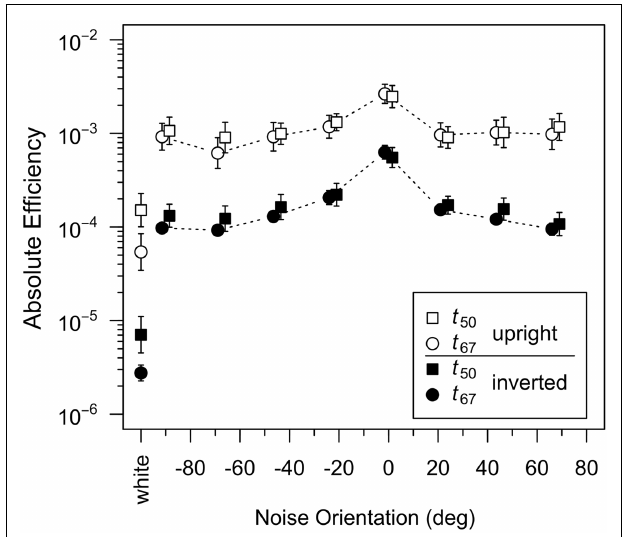
FIGURE 5 |Absolute efficiency measured in the t 50 and t 67 groups plotted as a function of noise orientation for upright and inverted faces. The leftmost symbols represent efficiency in the white noise condition. Absolute efficiency is defined as the squared ratio of ideal and human RMS contrast thresholds. Points for the t 50 and t 67 groups have been offset slightly for clarity. Error bars, where visible, represent ± 1